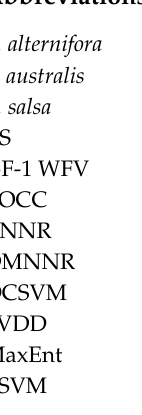
Figure S1. Results of feature selection for each SSA in Scenario 1 (Jan–Dec), using RF-RFE algorithm. Table S1. Results of the hyper-parameter optimization process showing the final values used in each